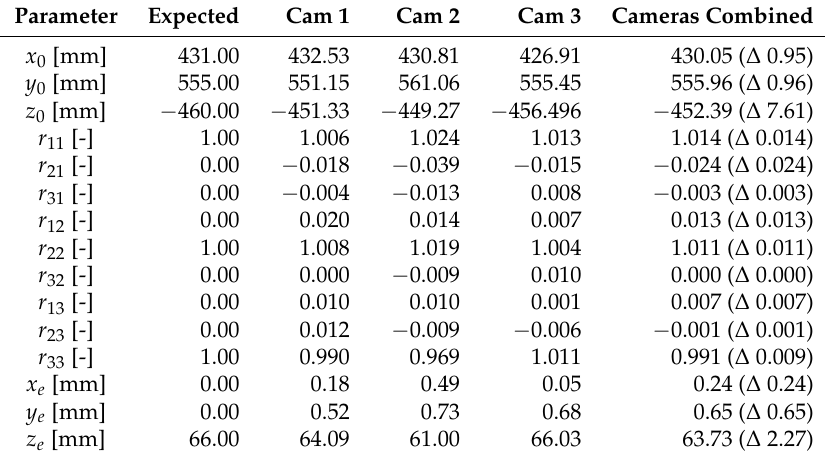
Table 4. Results of experiment A for the X vector after identification.